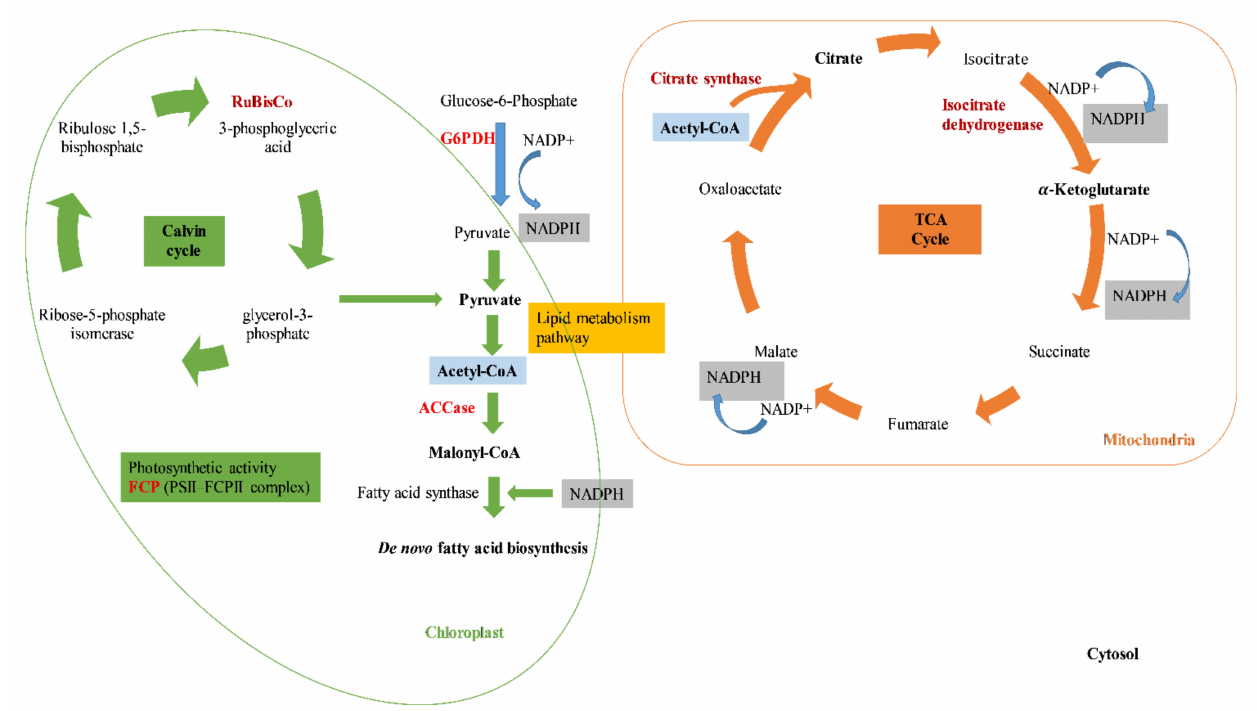
Figure 1. Representative diagram of the enzymes (in red) related to lipid biosynthesis and pho- tosynthesis pathways in Phaeodactylum tricornutum . Cytosol: glucose-6-phosphate dehydrogenase ( G6PDH ); chloroplast: acetyl-coenzyme A carboxylase ( ACCase ); citrate synthase ( Cit syn ); isocitrate dehydrogenase ( isocit DH ); mitochondria: ribulose-1,5-bisphospate carboxylase/oxygenase ( RBCL ); fucoxanthin-chlorophyll a/c binding protein B ( FCP B